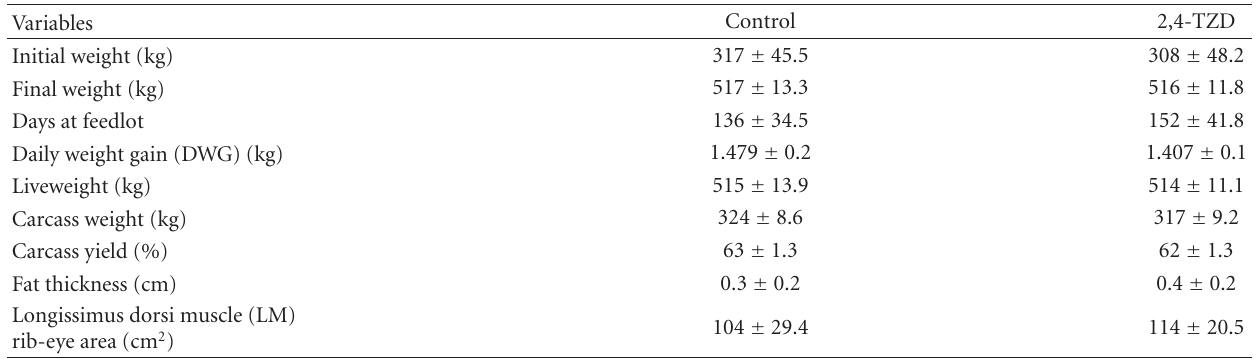
Table 1: Productive parameters in Limousin bulls with 2,4-Thiazolidinedione (TZD) (T) versus Control (C) animals.